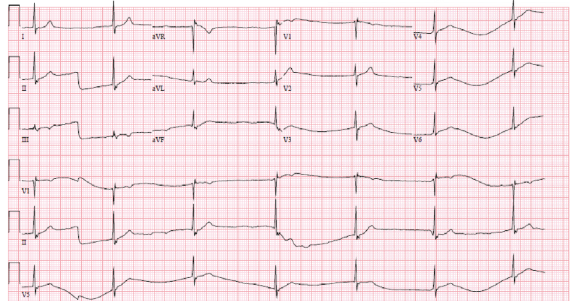
Figure 2: ECG, showing junctional bradycardia.